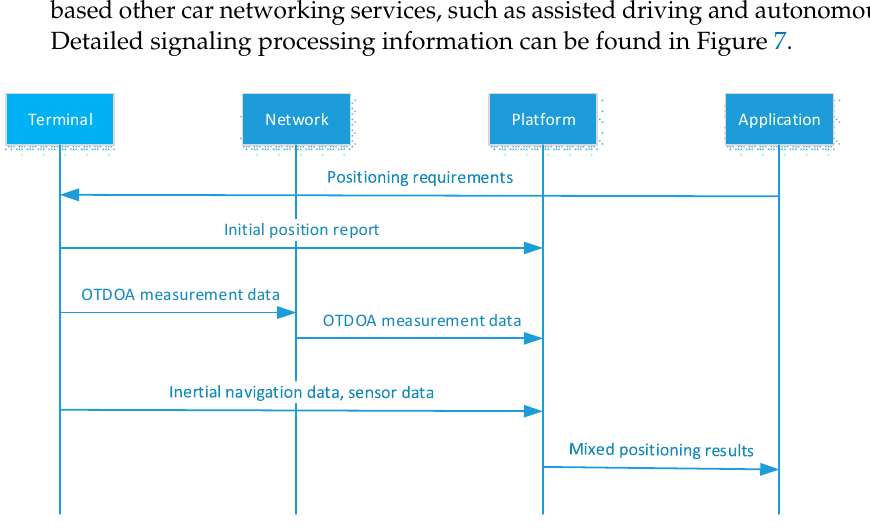
Figure 7. Signaling processing in the UE-assisted positioning architecture.